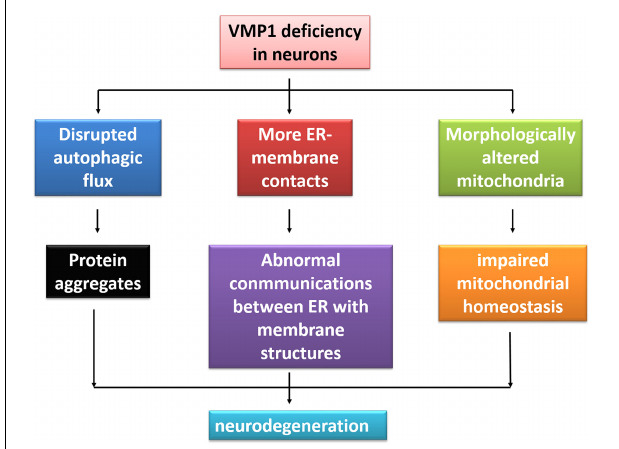
FIGURE 3 | The illustration of VMP1 deficiency in neurodegeneration. Deficiency of VMP1 results in more ER–membrane contacts, disrupted autophagic flux, and morphologically altered mitochondria, bringing the abnormal communications between ER with membrane contacts within cells, protein aggregates, and impaired mitochondrial homeostasis. Finally, this may lead to